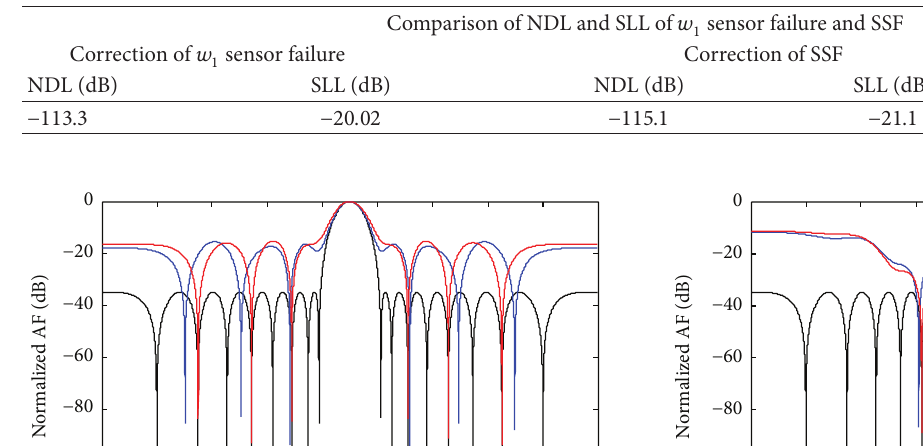
Table 8: Recovery of one nulls.